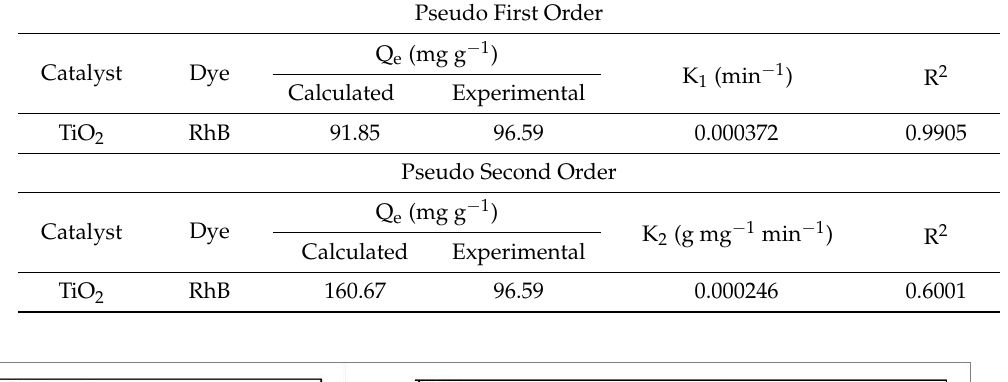
Table 1. Kinetics models of RhB dye degradation using biosynthesized TiO 2 nanoparticles.